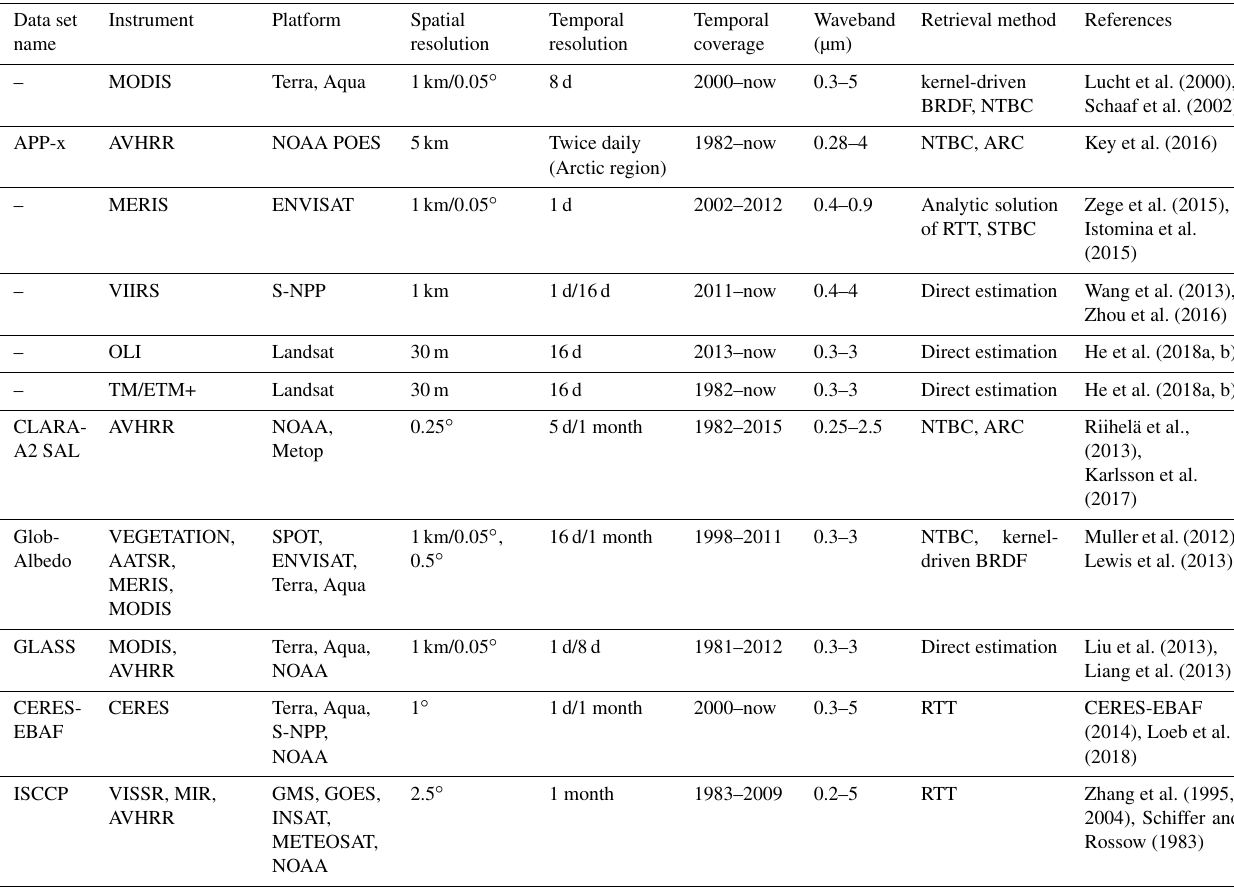
Table 1. Major surface broadband albedo products derived from satellite